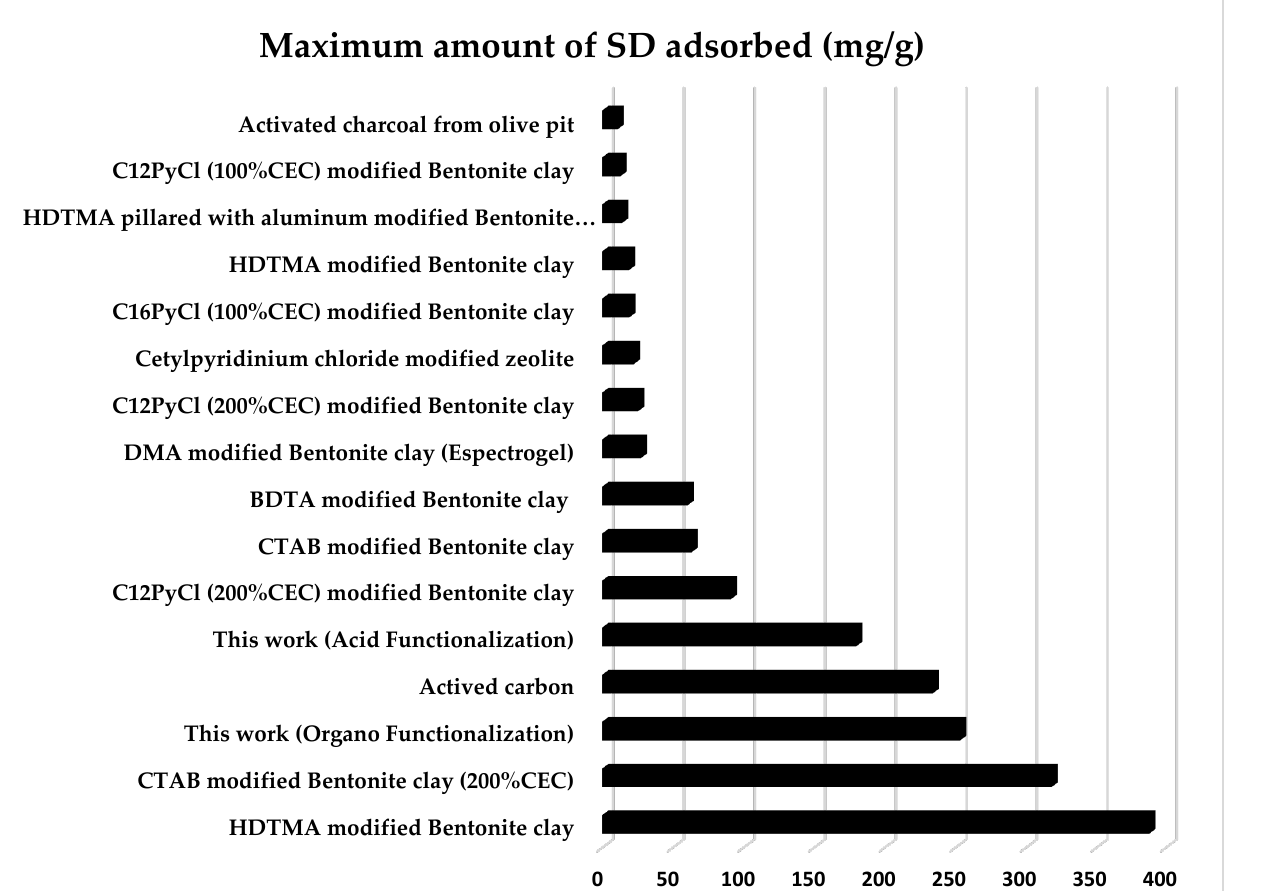
Figure 11. Comparison of the adsorption capacity of different adsorbents for the drug SD.